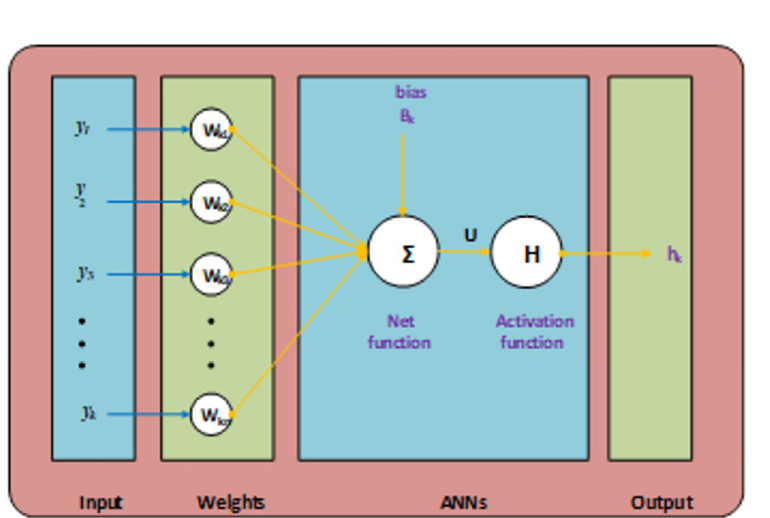
Fig 2. Proposed structure for a single